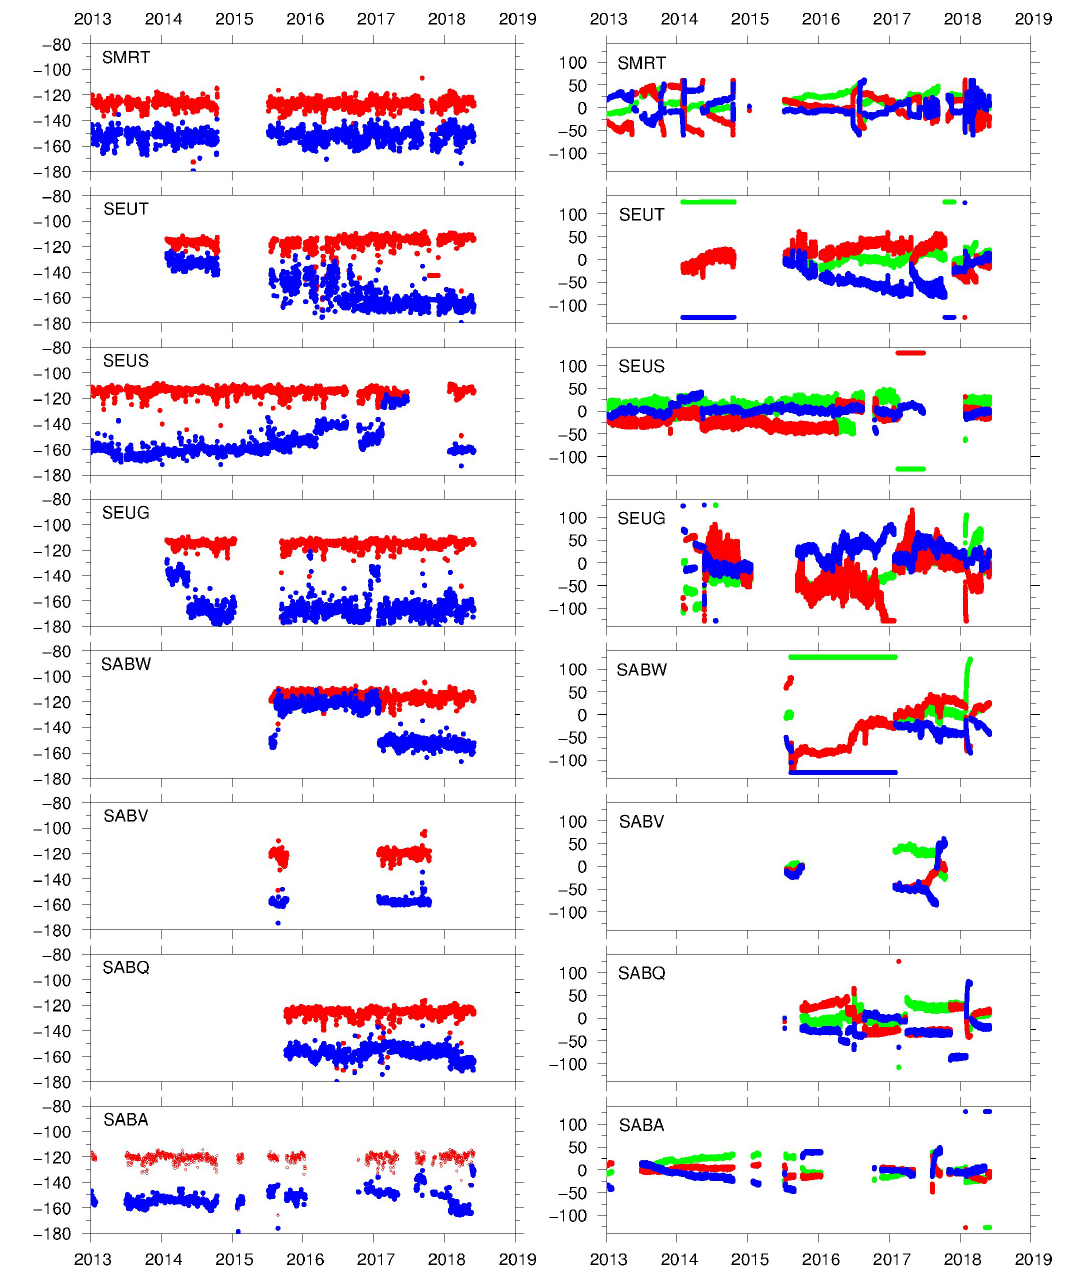
Figure 7. ( a ) Temporal variations of PSD (vertical component, dB rel. to m/s 2 ) for 0.01 Hz (blue) and 1.0 Hz (red); ( b ) seismometer mass position for each triaxial, oblique component: U (green), V (red) and W (blue) [26]. Data gaps are visible as interruptions of different time lengths in both PSD and mass position